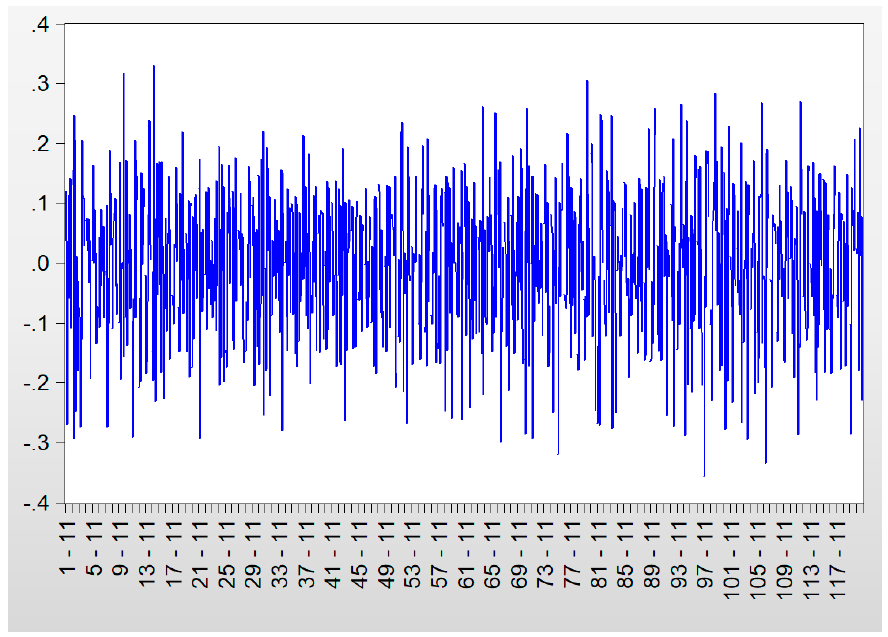
Figure 5. The concentration of quality voting ownership before CGS. Source: Author’s computations.